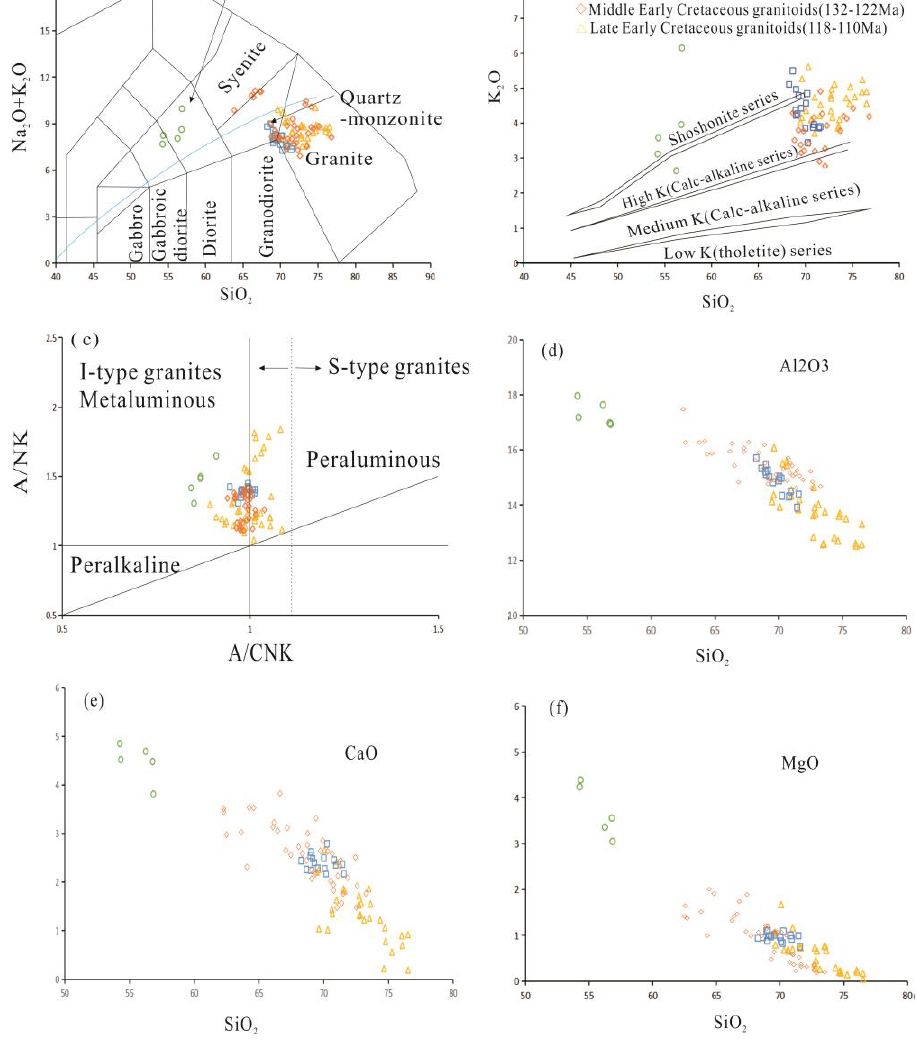
Figure 5. ( a ) Total alkali versus silica (TAS) diagram [61]. ( b ) K 2 O vs. SiO 2 classification diagram [62]. ( c ) A/NK (molar Al 2 O 3 /(Na 2 O + K 2 O)) vs. A/CNK (molar Al 2 O 3 /(CaO + Na 2 O + K 2 O)) diagram [63]. ( d – f ) Harker variation diagrams show the correlations of Al 2 O 3, MgO and CaO with SiO 2. The data for middle Early Cretaceous granitoids (132 – 122 Ma) [64 – 66] and Late Early Cretaceous granitoids (118 – 110 Ma) [49,50] previously published are also shown on the Figures. Granitoids of the